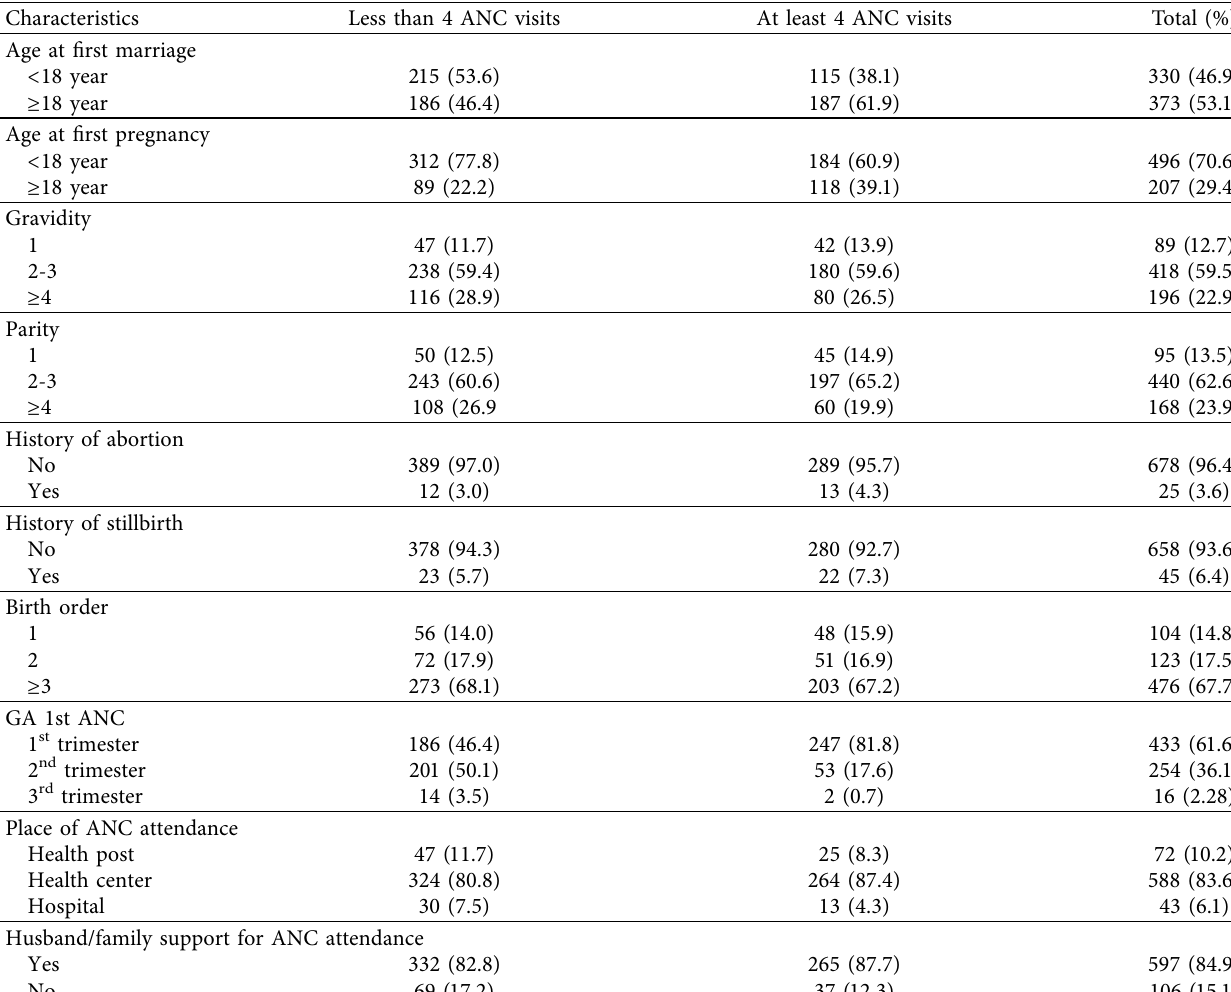
Table 2: Obstetric characteristics of women who gave birth in the past two years in the pastoral community, Northeast Ethiopia, 2020 ( n �